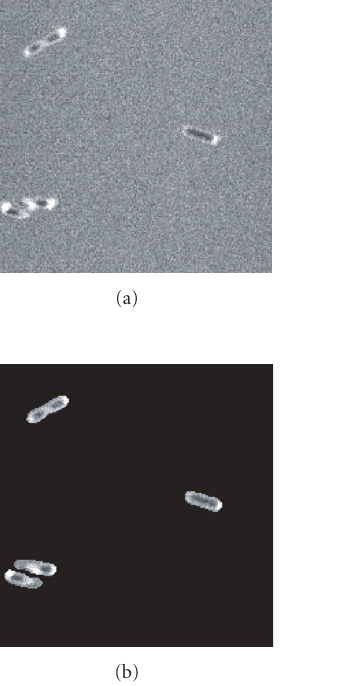
Figure 4: Images of E. coli cells expressing a GFP-fusion protein (a) before and (b) after fluorescence denoising.